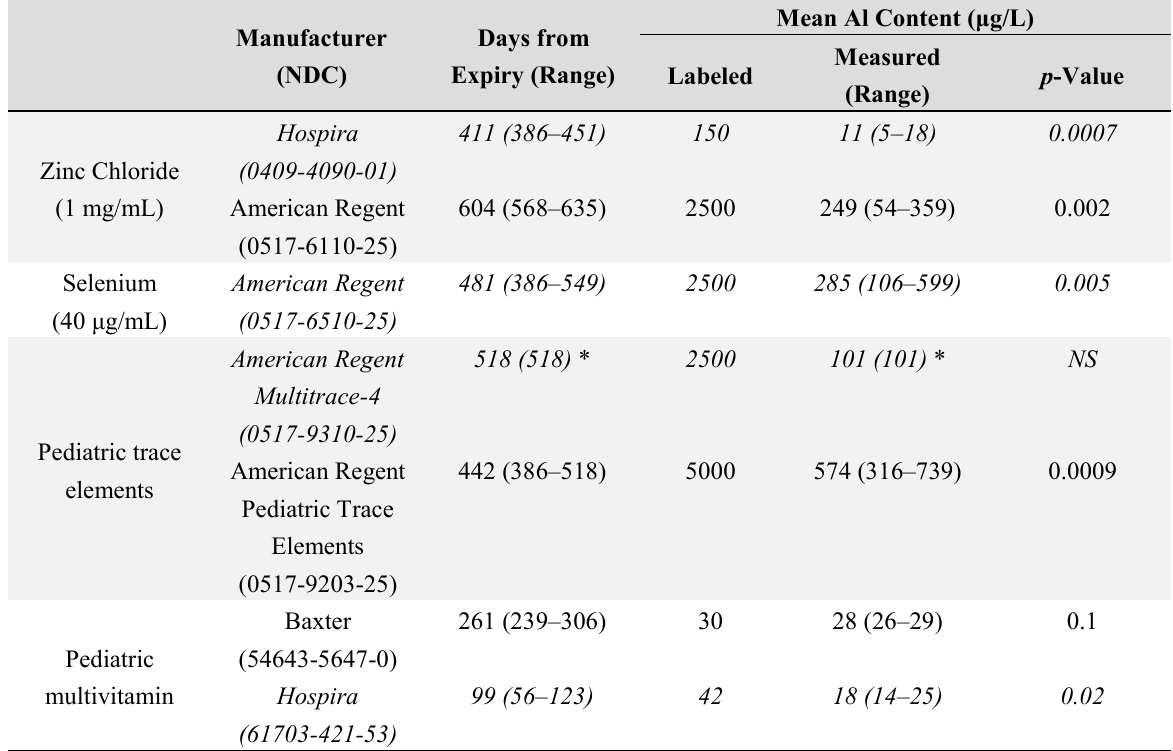
Table 3. Aluminum content of trace elements and multivitamins used in parenteral nutrition solutions. Reprinted with permission from